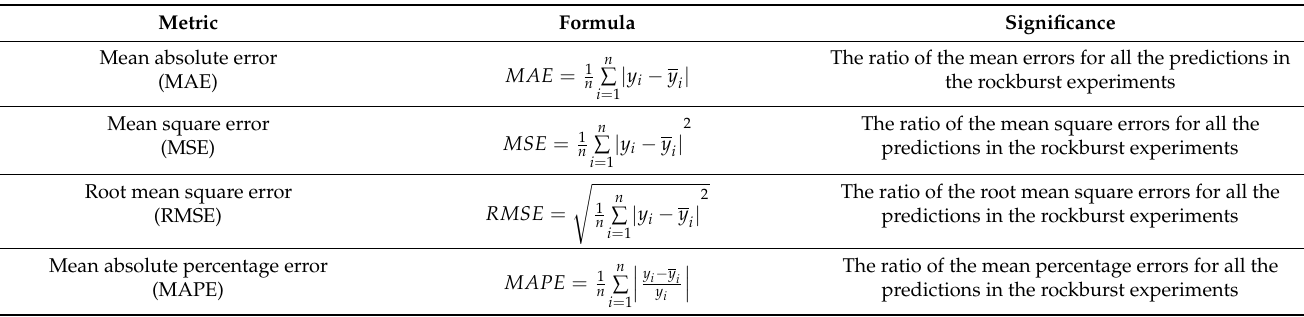
Table 1. The evaluation metrics.